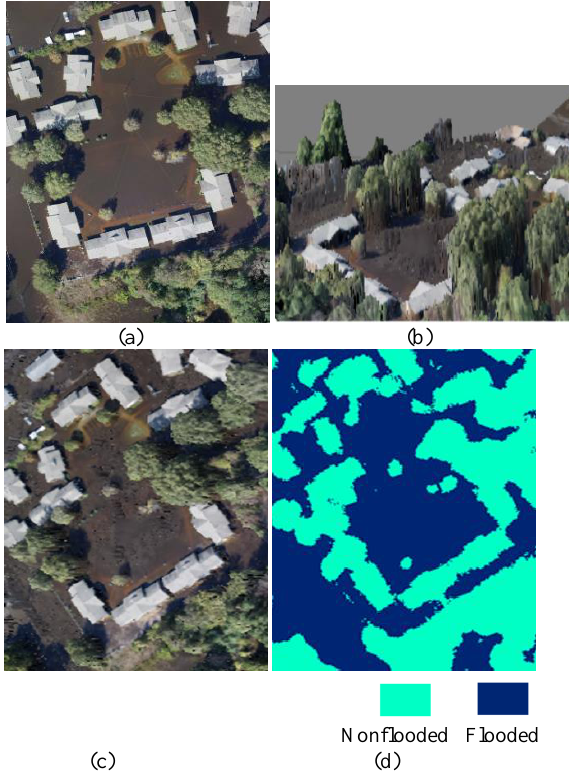
Figure 3. (a) Orthophoto; (b) SfM based 3D flood map (side view); (c) SfM based 3D flood map (top view); (d) FCN-8s